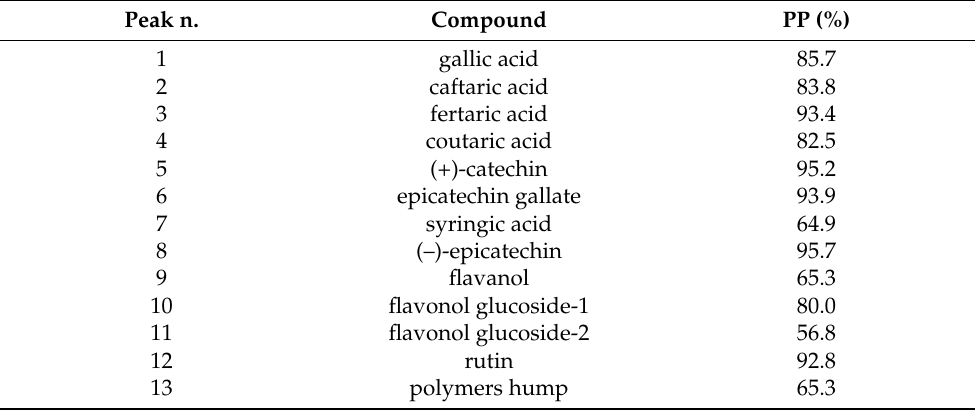
Table 3. Effect of the PP fining agent (concentration 2 g/L) on adsorption of phenolic compounds (%) from Sangiovese organic red wine. Values of HPLC peak area are normalized to percentage compared with control (100%). See Figure 3 for peak numbering.